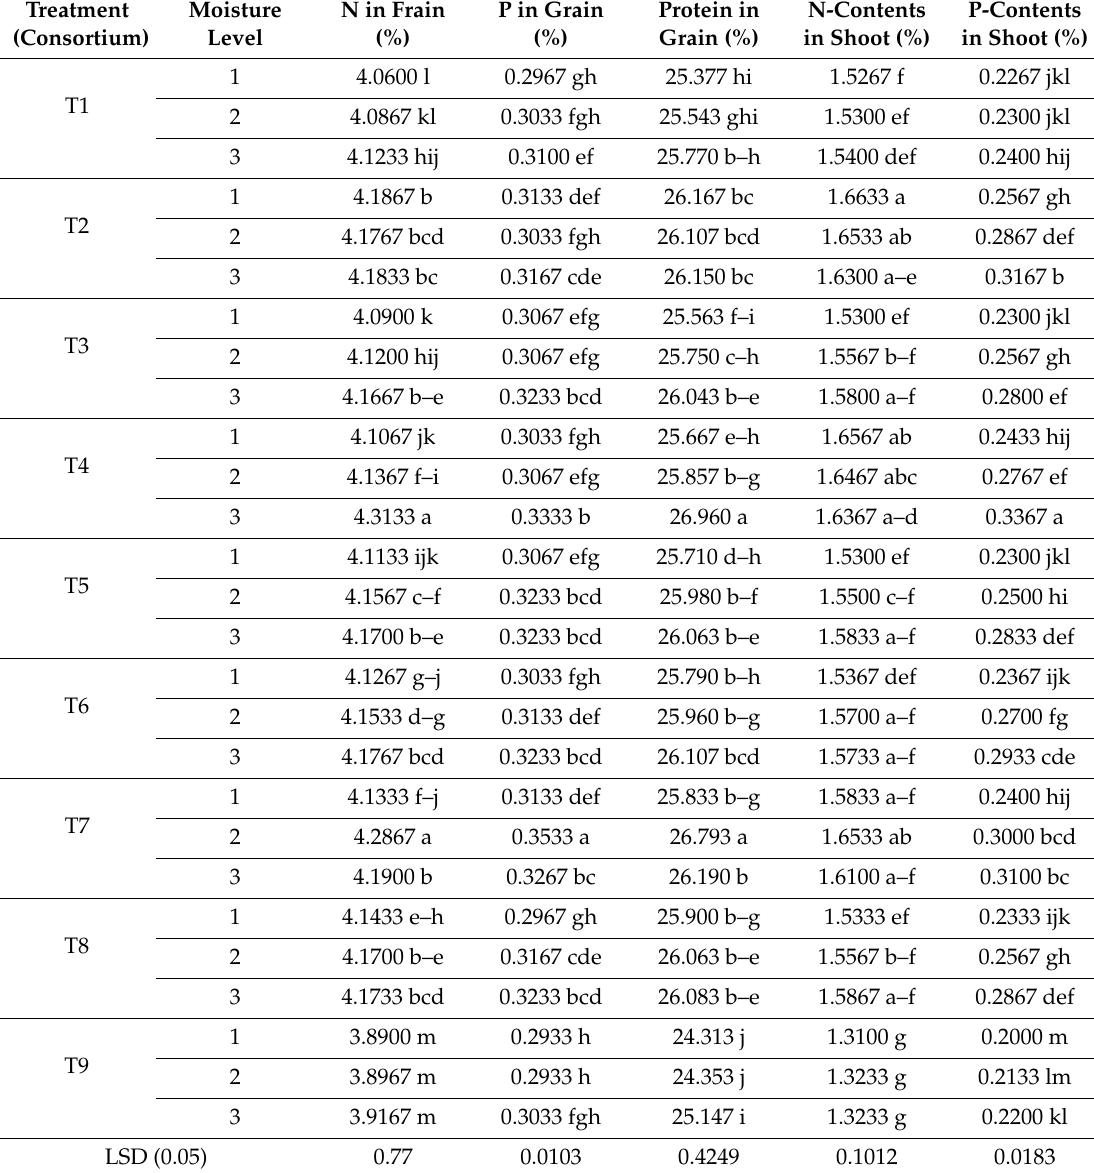
Table 5. E ff ect of inoculants on nutrient acquisition of chickpea at di ff erent moisture regimes. Treatment